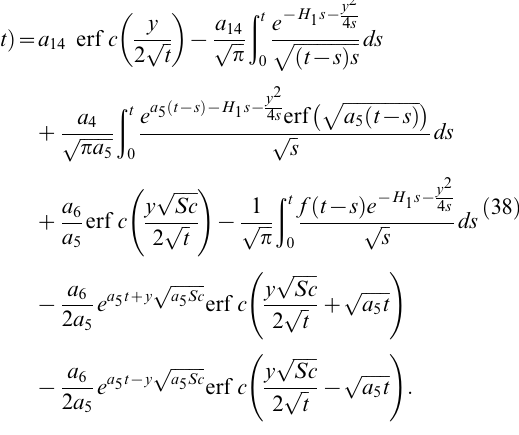
ffiffiffiffiffiffiffiffiffiffiffiffiffiffiffiffiffi a 5 t